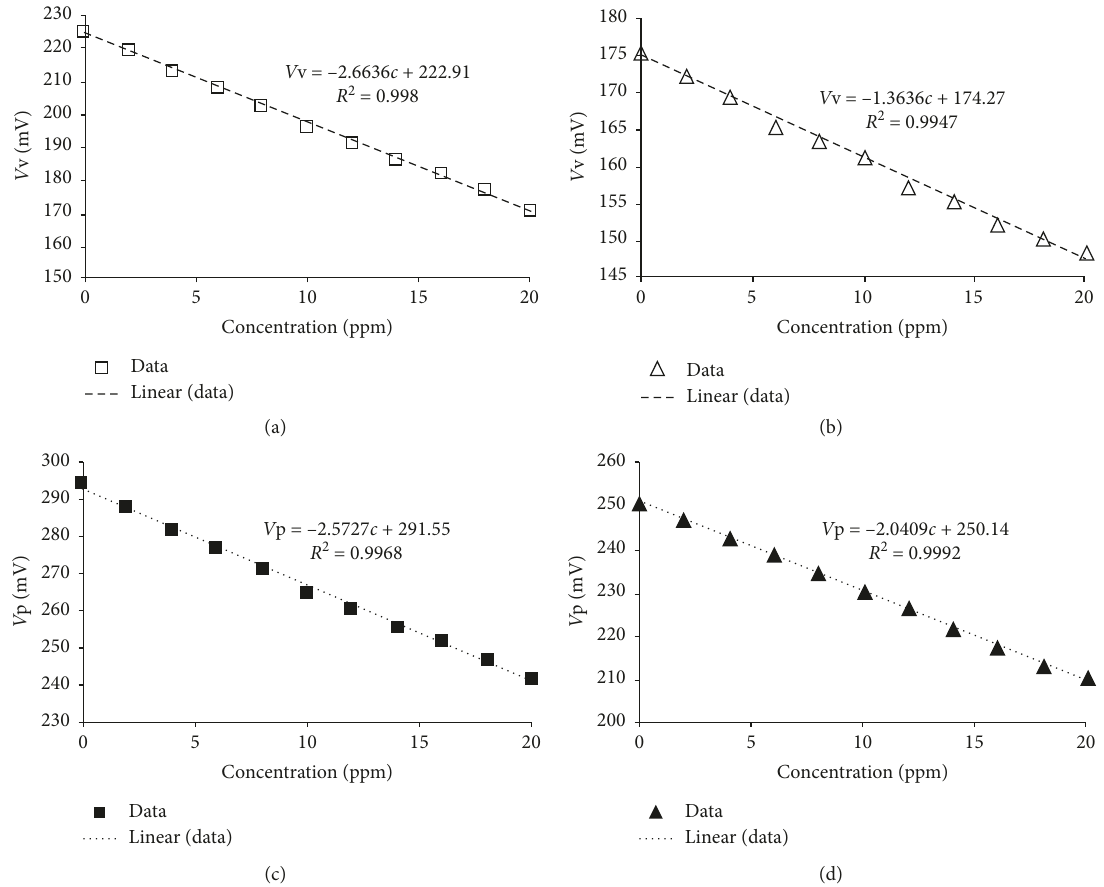
Figure 7: Graph of relation between rhodamine B concentration and value of V v for (a) concentric use and (b) a pair bundle probe. Also, relation between rhodamine B concentration and value of V p for (c) concentric use and (d) a pair bundle probe. Table 1: Characteristics of rhodamine B concentration sensor using concentric and a pair bundle probes. Value Parameters Concentric bundle